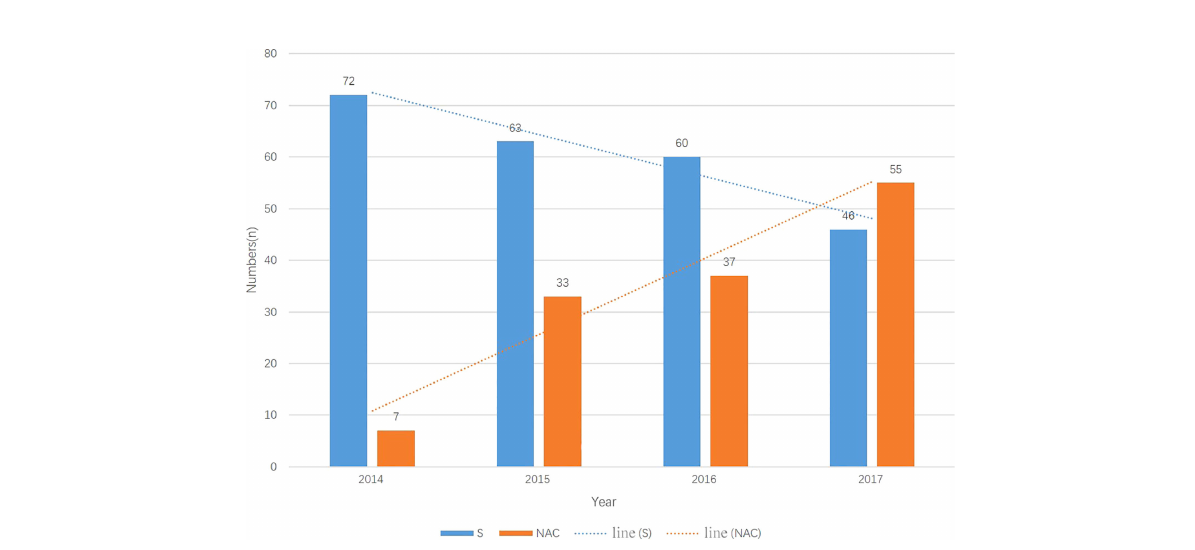
FIGURE 1 The number of patients in two groups each year from 2014-2017. The number of primary surgery patients droped every year meanwhile the muber of NAC patients increased every year. N, number; S, primary surgery; NAC, neoadjuvant